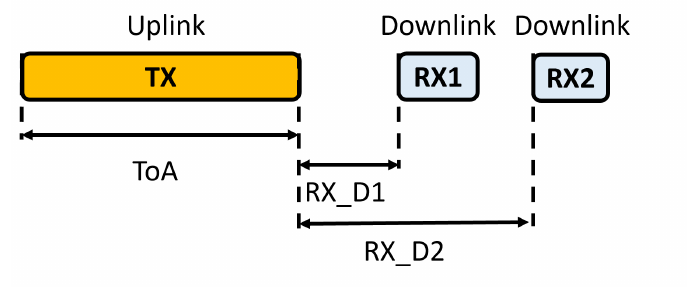
Figure 3. Timing of a Class A ED transmission (redrawn from